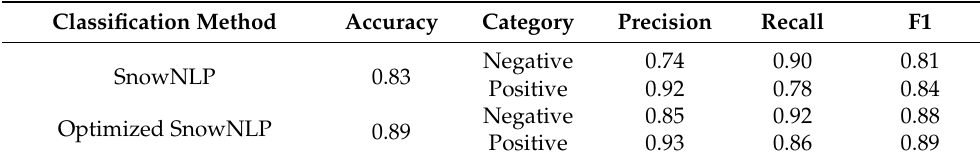
Table 2. Accuracy of sentiment